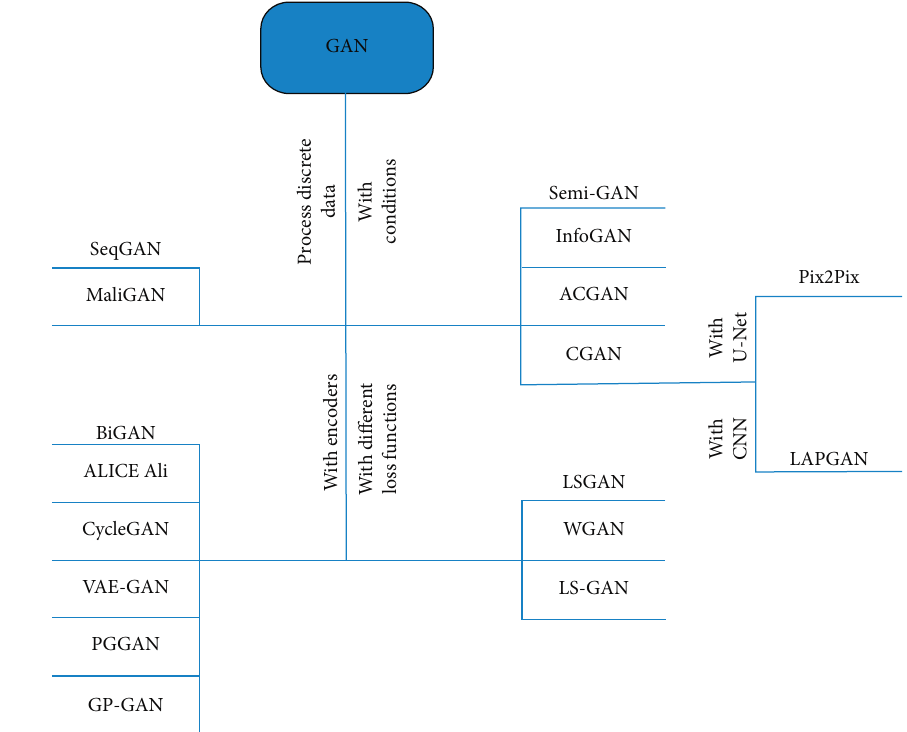
Figure 9: Evolution of the deep GAN with conditions, encoders, loss functions, and process discrete data